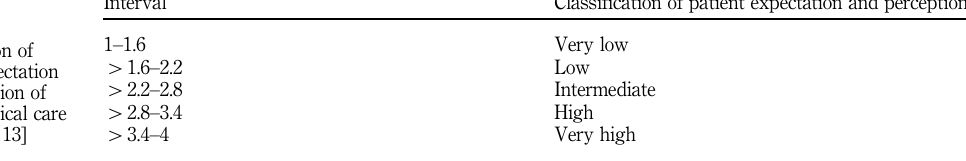
Table I. Classification of patient expectation and perception of pharmaceutical care services[12,